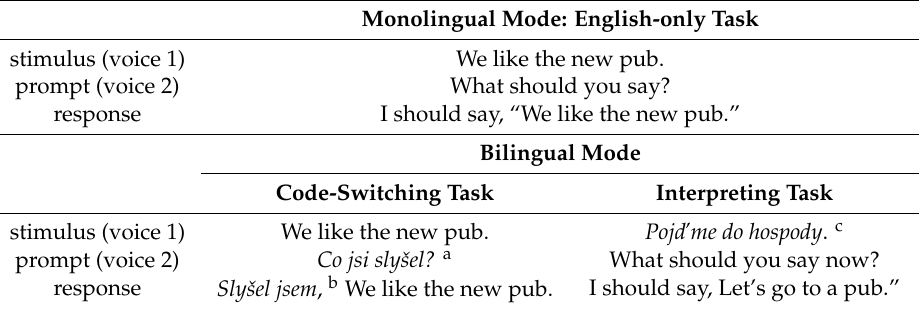
Table 1. One trial in the delayed repetition and translation tasks for each language